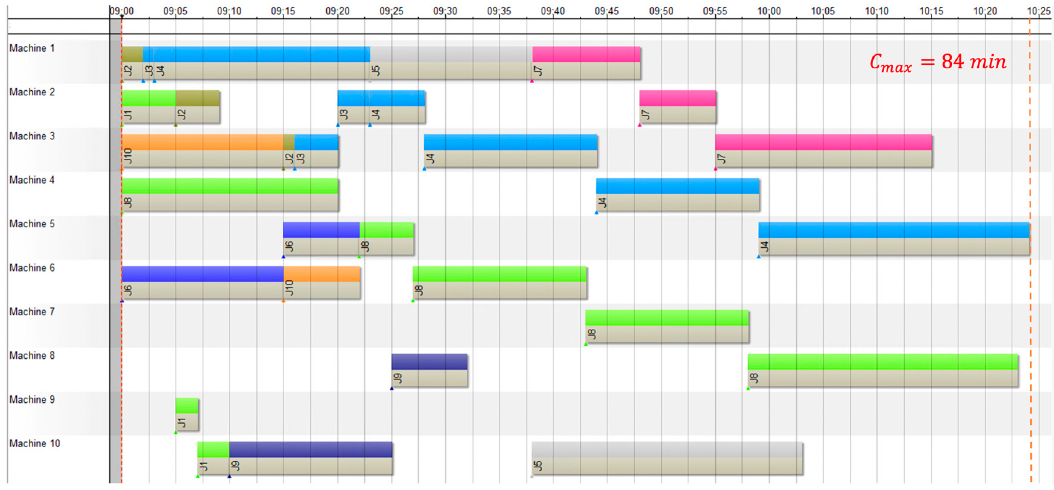
Figure 5. Gantt chart from Preactor AS.